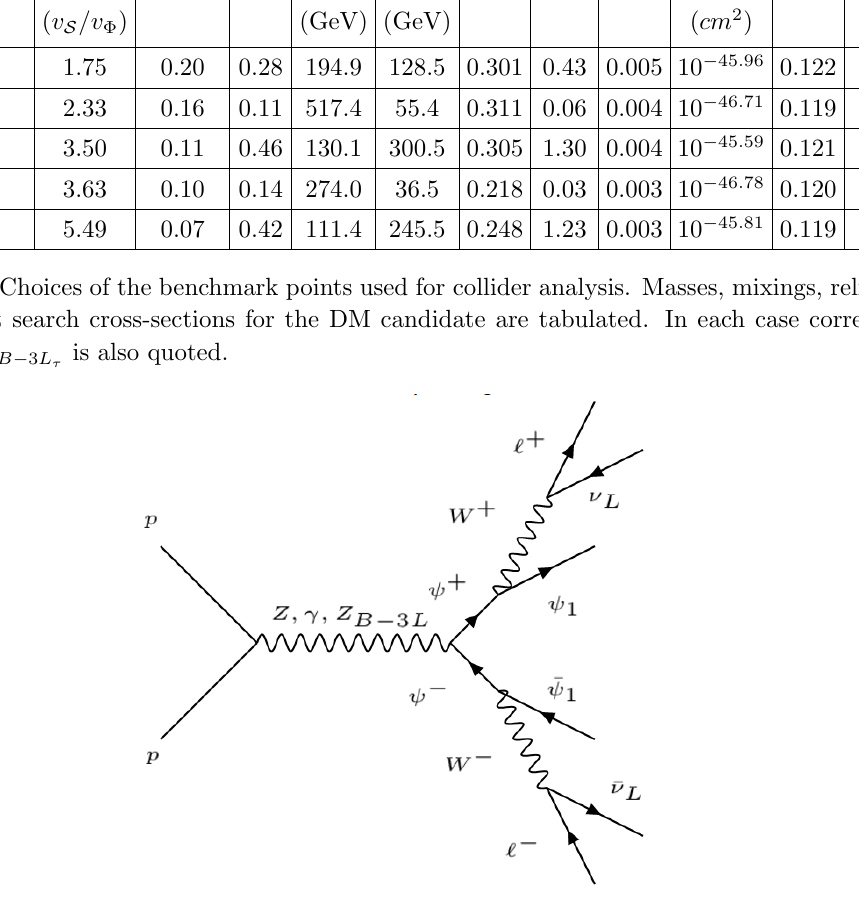
Figure 11 . Pair production of charged VLFs and their subsequent decay to OSD+ =E T (cid:12)nal state. (for (cid:12)xed VEV), which, in turn causes propagator suppression for (cid:6) production (via Z ) leading to decrease in cross-section. However, even if (cid:1) M is small, but M B (cid:0) 3 L (cid:28)